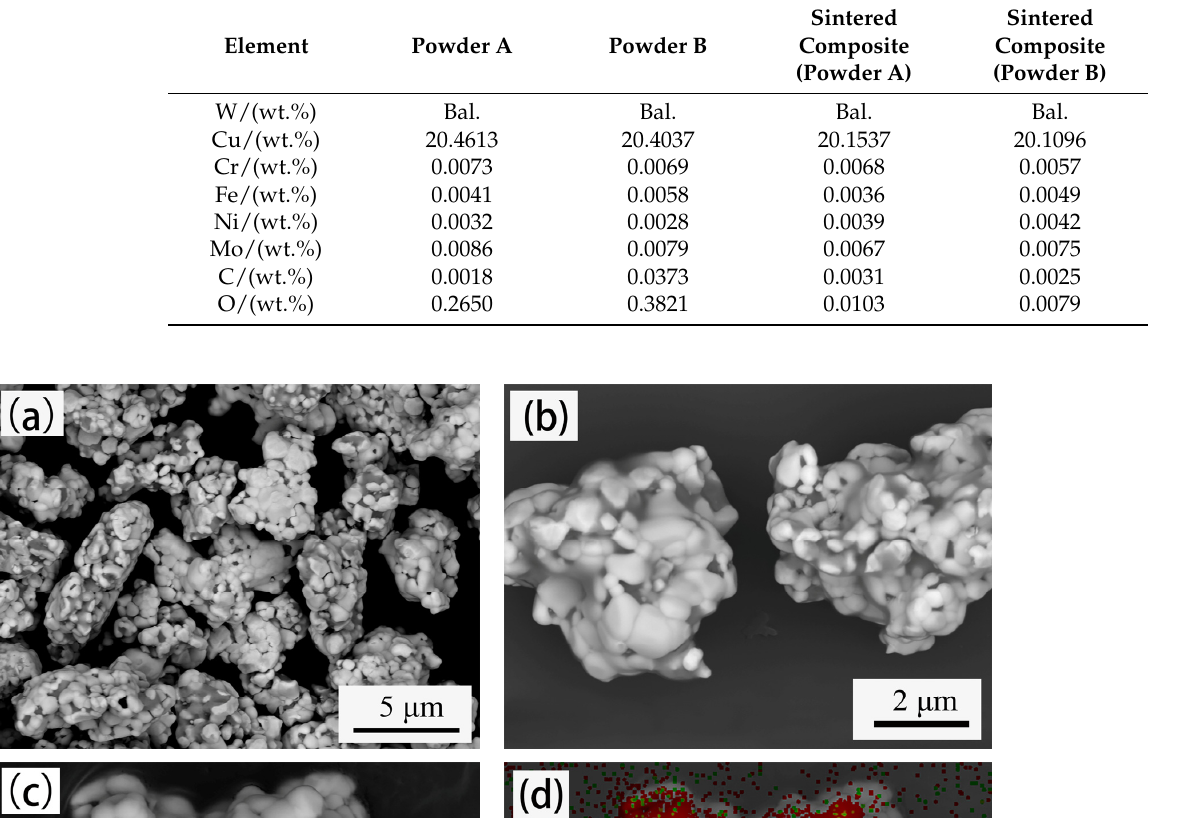
Table 1. Chemical composition of W–20% Cu powders and composite. Element Powder A Powder B W/(wt.%)